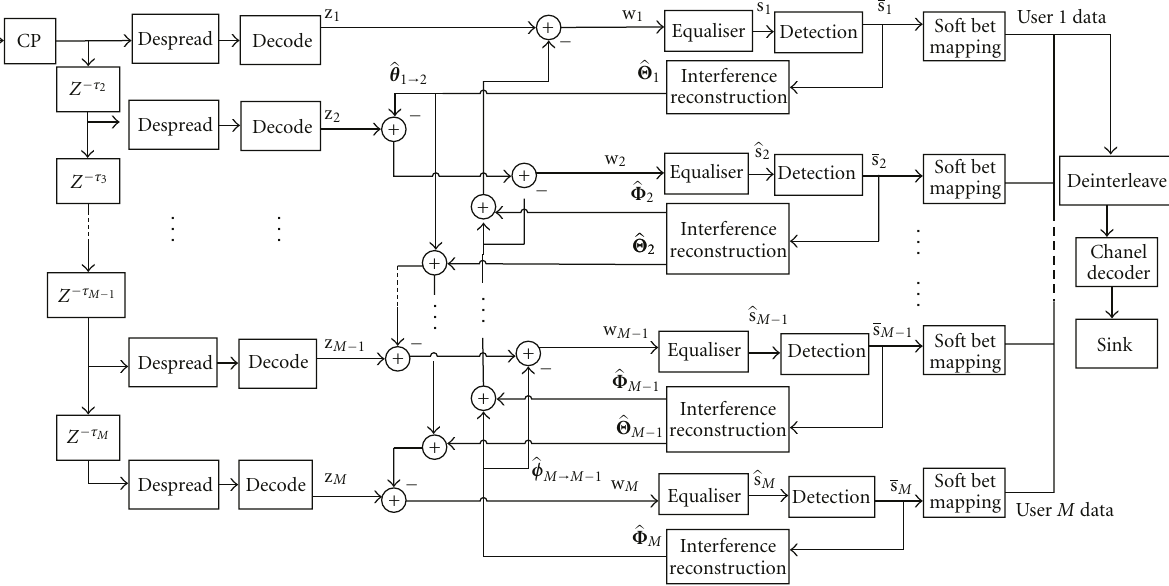
Figure 5: Receiver structure employing iterative SIC.